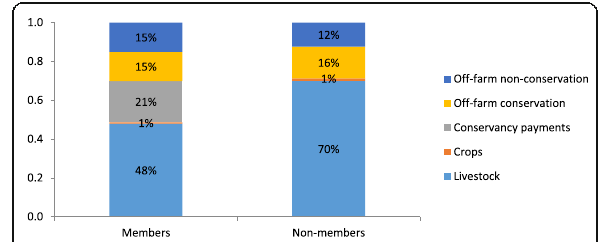
Figure 4 Proportion of gross annual household income from different activities, disaggregated into conservancy members ( n =127) and non- member ( n =121) households